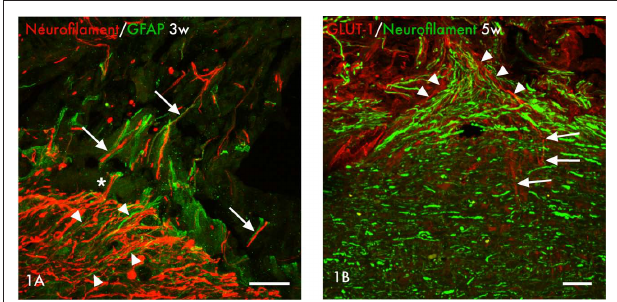
FiguRE 1 | (A) Axons (neurofilament, red) and astrocytes (GFAP, green) are seen at the border between the central and peripheral parts of the spinal cord at the site of replantation of the avulsed ventral root at 3 weeks after injury. In the more central parts astrocyte processes can be seen growing alongside axons (arrowheads) in a pattern that can also be found in the more peripheral parts where axons and astrocytic processess do align (arrows). Marked is also one single axon that seemingly grow from the central parts of the cord in to the peripheral nerve graft alongside astrocytic processess (asterisk*). Scale bar 50 μm. (B) Micrographs showing the relation between regenerating blood vessels, shown with marker for GLUT-1 (red), and regenerating axons, shown with marker for neurofilament (green), at the replantation site at 5 weeks after replantation of avulsed ventral roots. Note how blood vessels grow from the CNS compartment (arrows) to the PNS compartment (arrowheads) alongside the axons (green). Scale bar 50